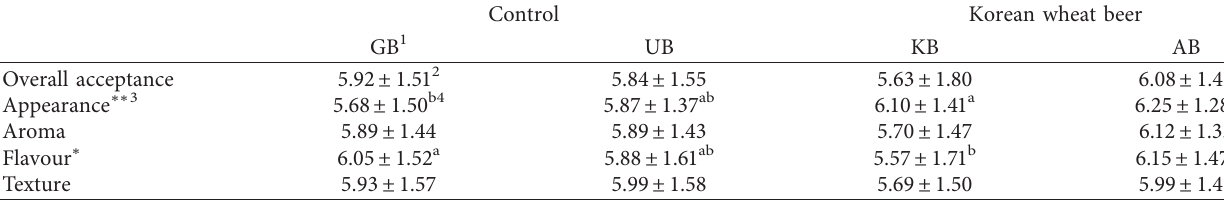
Table 3: Consumer ( n � 102) acceptability of wheat beer